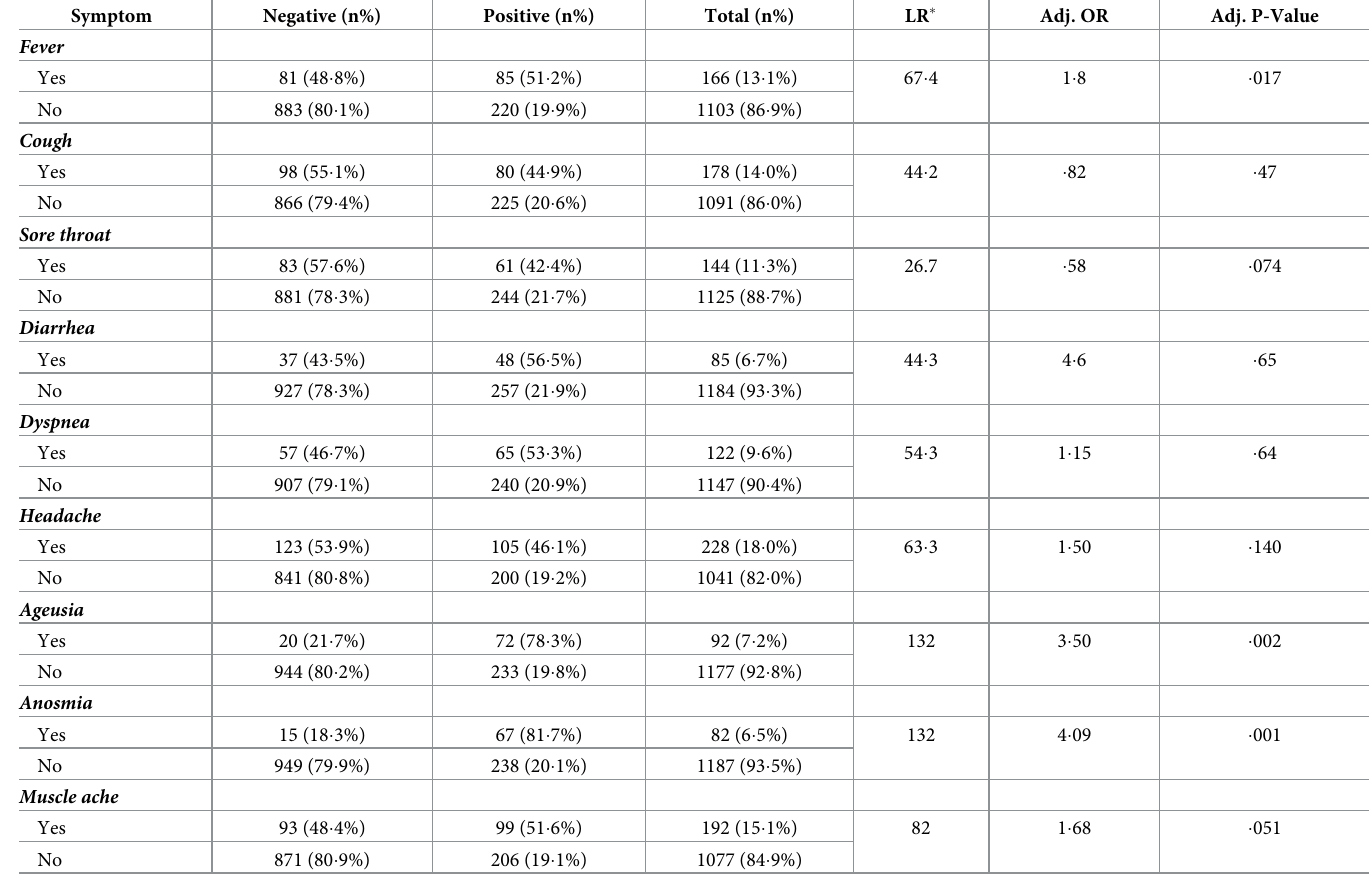
Table 3. SARS-CoV-2 serology and COVID-19